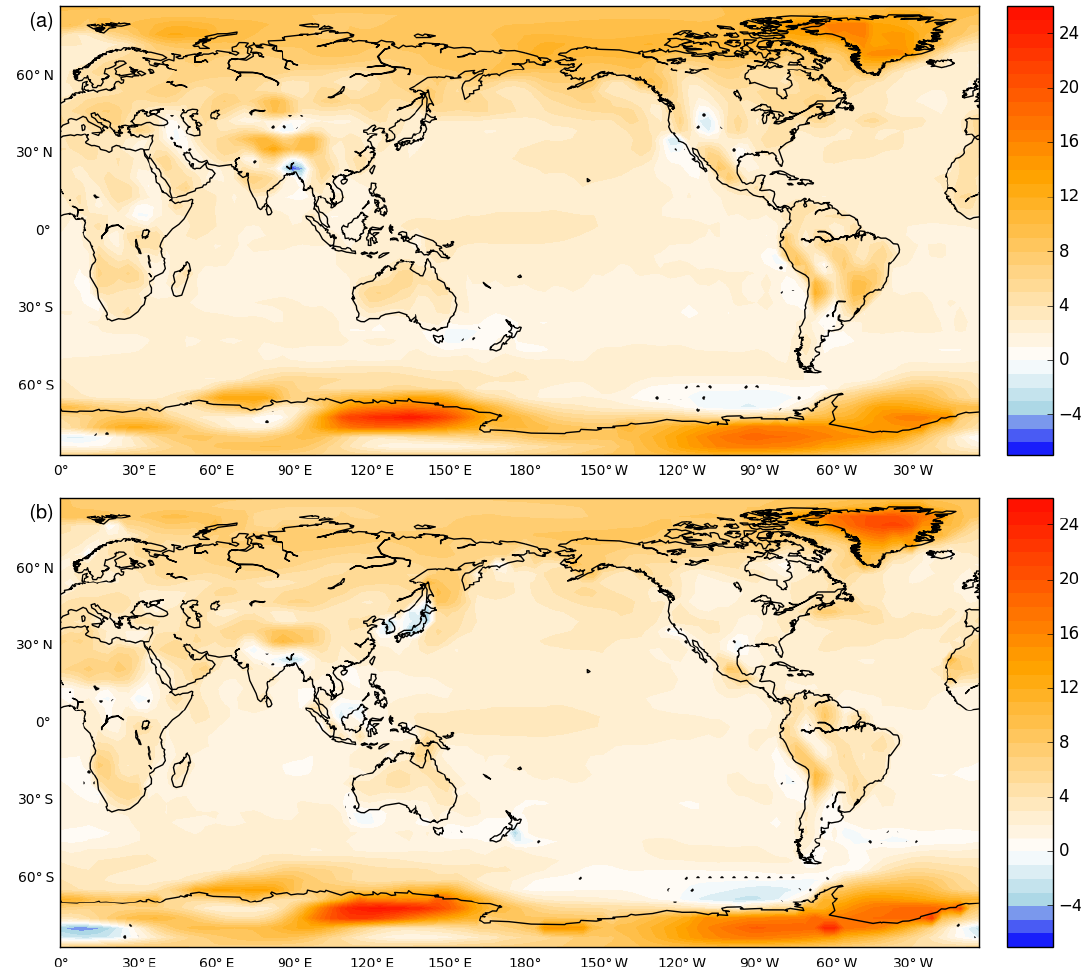
Figure 2. Annual mean SAT ( ◦ C) anomalies between core mid-Pliocene simulations for PlioMIP1 and PlioMIP2, with their respective pre- industrial simulations (PI_1 and PI_2). (a) Climatological anomaly that has been calculated over 100 years for PlioMIP1; panel (b) is as panel (a) , but for Eoi400. Stipples (black dots) show regions of statistically insignificant